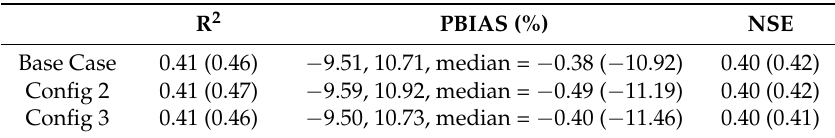
Table 8. Performance metrics of the ridge regression (RR) models—Verification period (numbers outside of brackets are the medians of 50 random verification runs (for PBIAS, the minimum, maximum, and the median are listed); bracketed numbers are metrics of the continuous verification). R